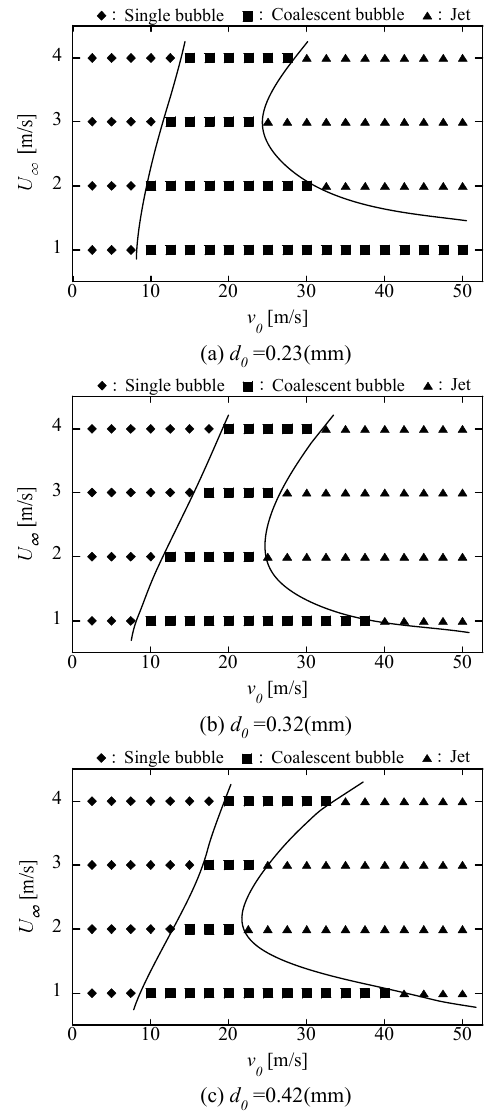
Fig.4 Map of the flow configuration near the